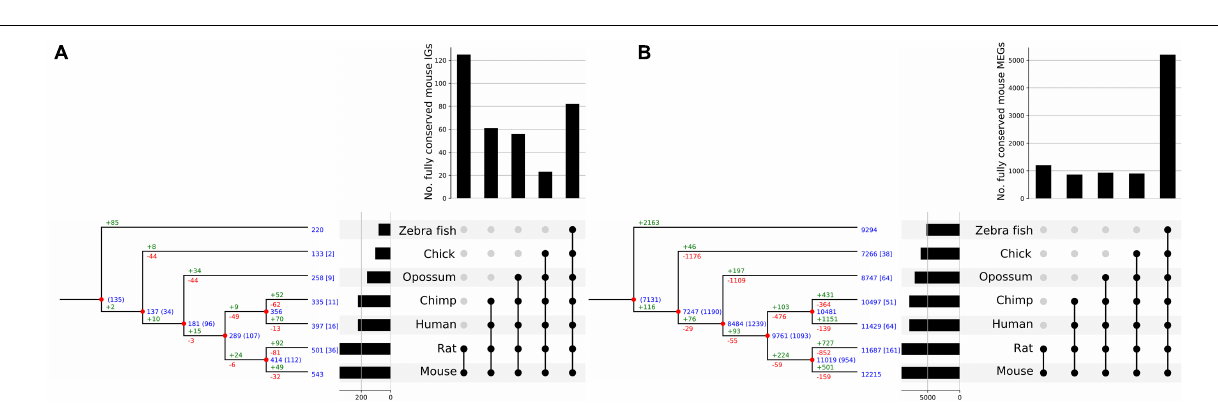
FIGURE 9 | Clusterization of conserved mouse IG and MEG orthologs. Reconciliation trees representing the evolutionary history of mouse IG (A) , and MEG (B) gene families. Blue numbers at each internal node represent the number of ancestral genes found in that clade that were inherited by an older ancestor. Blue numbers in brackets represent ancestral genes that might be generated at that evolutionary point, since they are not found in an outgroup of the clade. Green numbers represent gene gains due to duplication events and red numbers represent gene losses. Numbers at the tip of the branches represent the number of orthologous genes in other species, and numbers in square brackets represent the number of out-paralogs (genes that arose via duplication before speciation) in other species in the study. Orthologous genes are grouped by age determined by the clade they are conserved in; the histogram on top of the upset plot shows the number of genes that are specific to each clade; the histogram to the left of the upset plot represents the number of mouse orthologs for each species. Moreover, the bar for mouse shows the number of IGs for which an ortholog in another species was